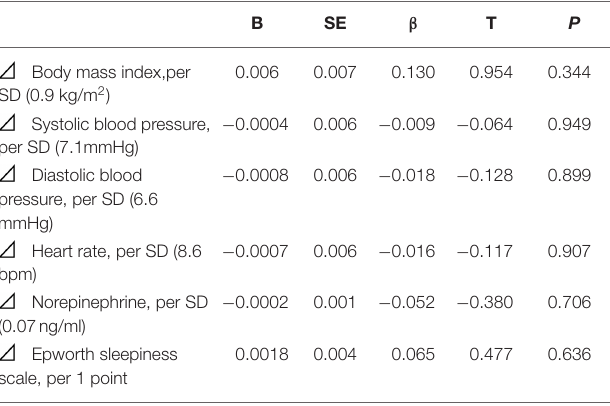
TABLE 4 | The association of change of the variables and LVEF improvement. TABLE 5 | Multiple regression analysis for identify variables associated with LVEF